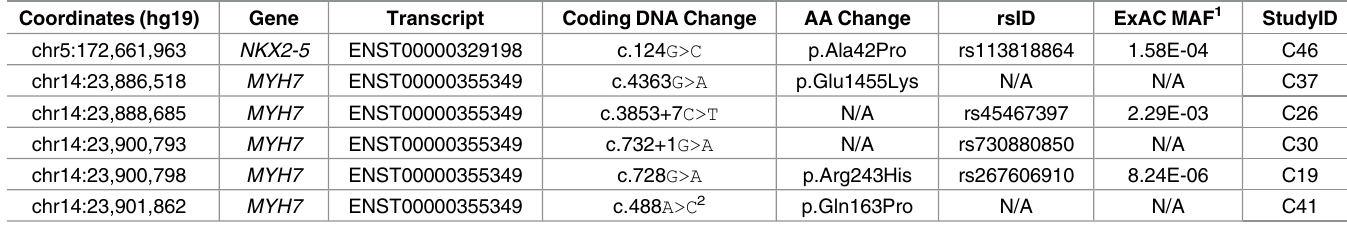
Table 3. Rare sequence variants validated in known EA genes.